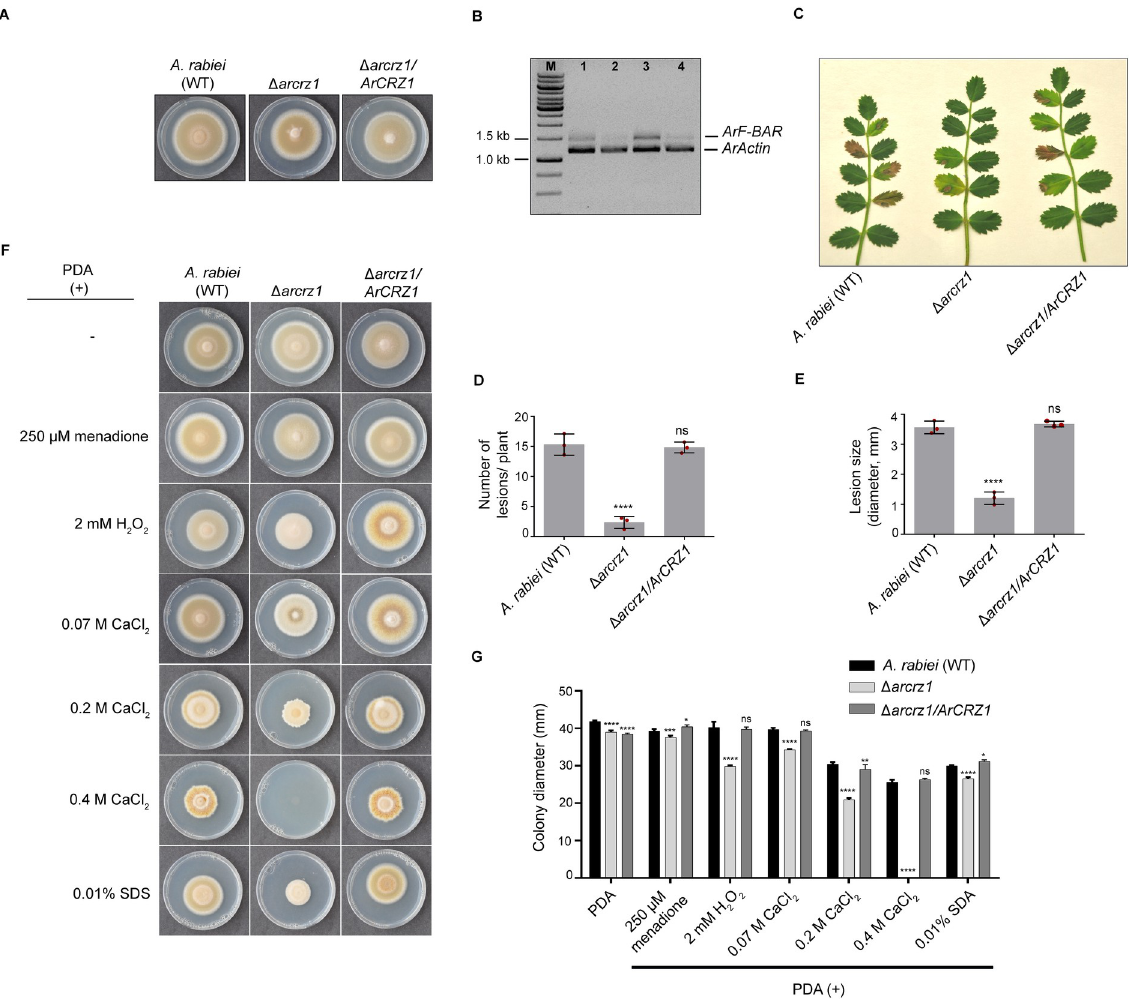
Fig 9. ArCRZ1 regulates ArF-BAR transcription and A . rabiei virulence. (A) Vegetative growth phenotype of 7 days old A . rabiei (WT), Δ arcrz1 and Δ arcrz1/ArCRZ1 strains grown on PDA plate. (B) Expression analysis of ArF-BAR gene in Δ arcrz1 through semi-quantitative PCR. Lane 1 and 2 shows ArF-BAR expression in mycelia of A . rabiei (WT) and Δ arcrz1 while lane 3 and 4 shows ArF-BAR expression in A . rabiei (WT) and Δ arcrz1 after 0.5 h treatment with 250 μ M menadione to the axenic culture of mycelia in PDB. (C) Representative image of disease symptoms obtained on Ascochyta blight susceptible chickpea 6 days post inoculation (dpi) of A . rabiei (WT), Δ arcrz1 , and Δ arcrz1/ ArCRZ1 strains. (D) Statistical analysis of the AB disease symptoms on chickpea plants inoculated with three different A . rabiei strains. The height of bar in graph shows the mean value of lesions per plant (WT = 15.31 ± 1.44, Δ arcrz1 = 2.32 ± 0.80, and Δ arcrz1/ArCRZ1 = 14.82 ± 0.73). (E) The bar height in graph represents the mean value of lesion size, in diameter (WT = 4.04 mm ± 0.41, Δ arcrz1 = 2.03 mm ± 0.33, and Δ arcrz1/ArCRZ1 = 3.98 mm ± 0.56). The mean and standard deviation ( ± ) were calculated from three biological replicates, counting at least 20 plants for each replicate. These results were quantified using one-way ANOVA, compared with the control ( ���� p < 0.0001). Each red dot represents the mean value of biological replicate. (F) Colony morphology and growth assay of WT A . rabiei , Δ arcrz1 mutant and complemented Δ arcrz1/ArCRZ1 fungal strains observed under various stress conditions after 10 days incubation at 22˚C. PDA medium was separately supplemented with 250 μ M menadione, 2 mM H 2 O 2 , 0.07 M, 0.2 M, 0.4 M CaCl 2 and 0.01% SDS. The Δ arcrz1 mutant exhibited enhanced sensitivity towards stress conditions as compared to A . rabiei (WT). The mutant strain was highly sensitive towards CaCl 2 and failed to grow at 0.4 M CaCl 2 . (G) The bar graph represents diameter values (mean and SD) of the radial growth for three fungal strains. All the growth assays were performed in triplicates. The results were quantified using two-way ANOVA, Tukey’s multiple comparisons. The statically significant differences are shown with ���� p < 0.0001, ��� p < 0.001, �� p < 0.01, � p < 0.05, ns =